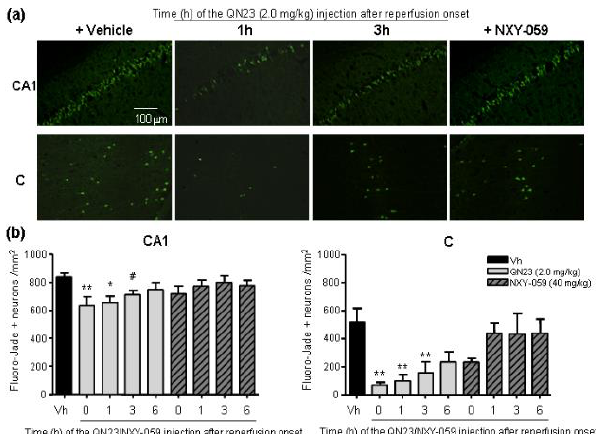
Figure 4. Therapeutic window of QN23 studied by Fluoro-Jade B assay (neuronal death). Ischemic animals were treated with vehicle (Vh), QN23 (2.0 mg/kg), or NXY-059 (40 mg/kg) by an intravenous injection at reperfusion onset (0 h), or at 1, 3, or 6 h of reperfusion after global cerebral ischemia. Neuroprotection was evaluated after 5 days of post-ischemic reperfusion. ( a ) Representative images of Fluoro-Jade B-stained hippocampal CA1 (CA1) and cortical (C) brain sections of vehicle- and QN23-treated animals at 1 h or 3 h of reperfusion and NXY-059-treated animals at 0 h of reperfusion. Dead neurons observed after Fluoro-Jade B staining within the CA1 and C regions were imaged by fluorescence microscopy (in green) and counted as described in the Materials and Methods section. ( b ) Bar graphs represent the neuronal death quantified in brain sections from vehicle-, QN23-, and NXY-059-treated animals in CA1 and C regions. For each group, 6–10 independent animals were averaged (10 animals treated with vehicle, 6–7 animals per QN23 treatment, and 6 animals per NXY-059 treatment); error bars indicate the SE. * p < 0.05 and ** p < 0.01, compared with vehicle (Vh) by Dunnett’s post-test, and # p < 0.05, by Student’s t test, after ANOVA.